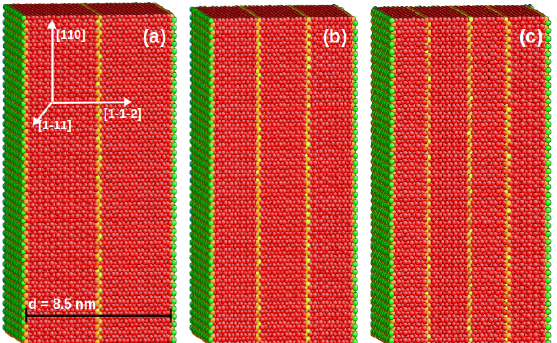
Figure 1. The initial configuration of BCC Fe nanowires containing ( a ) one, ( b ) two, and ( c ) three twin boundaries. The corresponding twin boundary spacings is of 4.25, 2.83 and 2.12 nm, respectively. The nanowire orientation and cross-section width ( d ) are indicated in ( a ). The atoms are coloured according to their centro-symmetry parameter